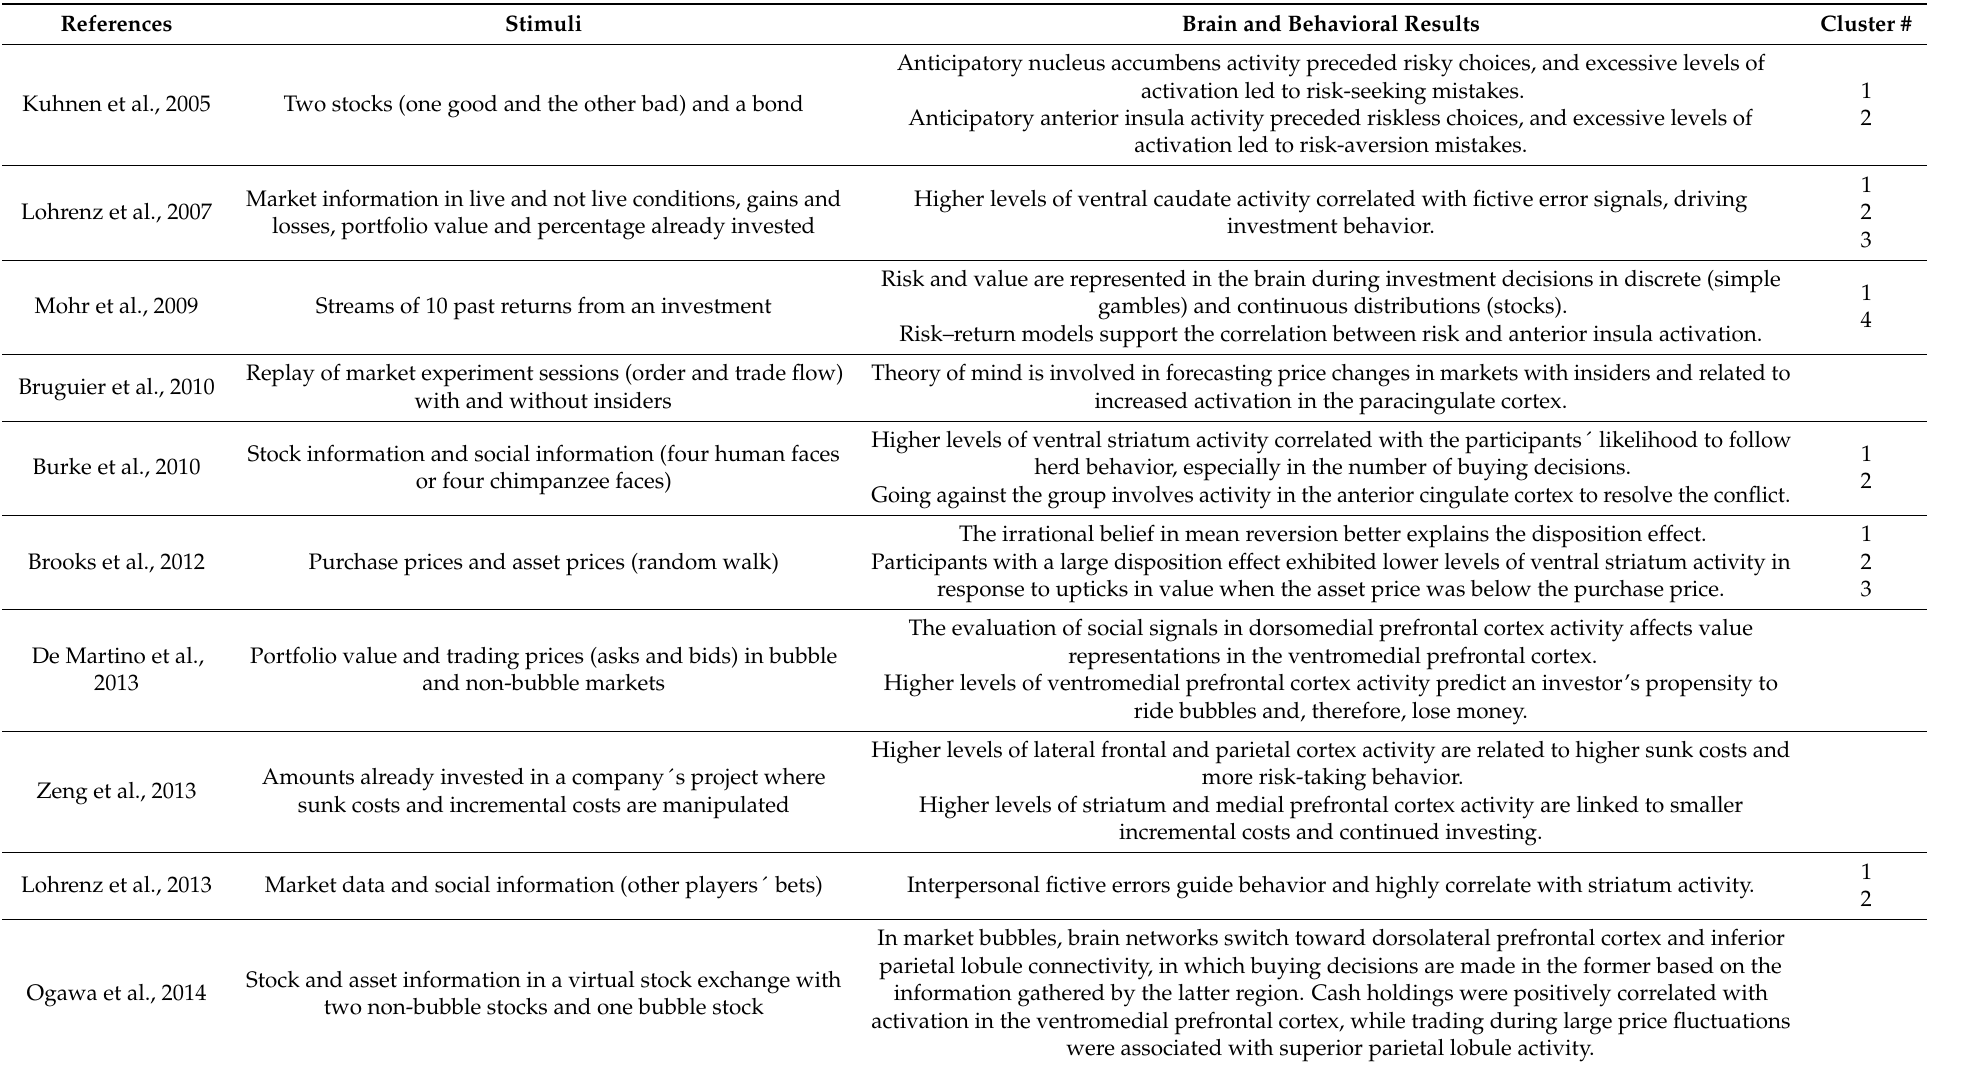
Table 2. Investment decision-making studies included in the